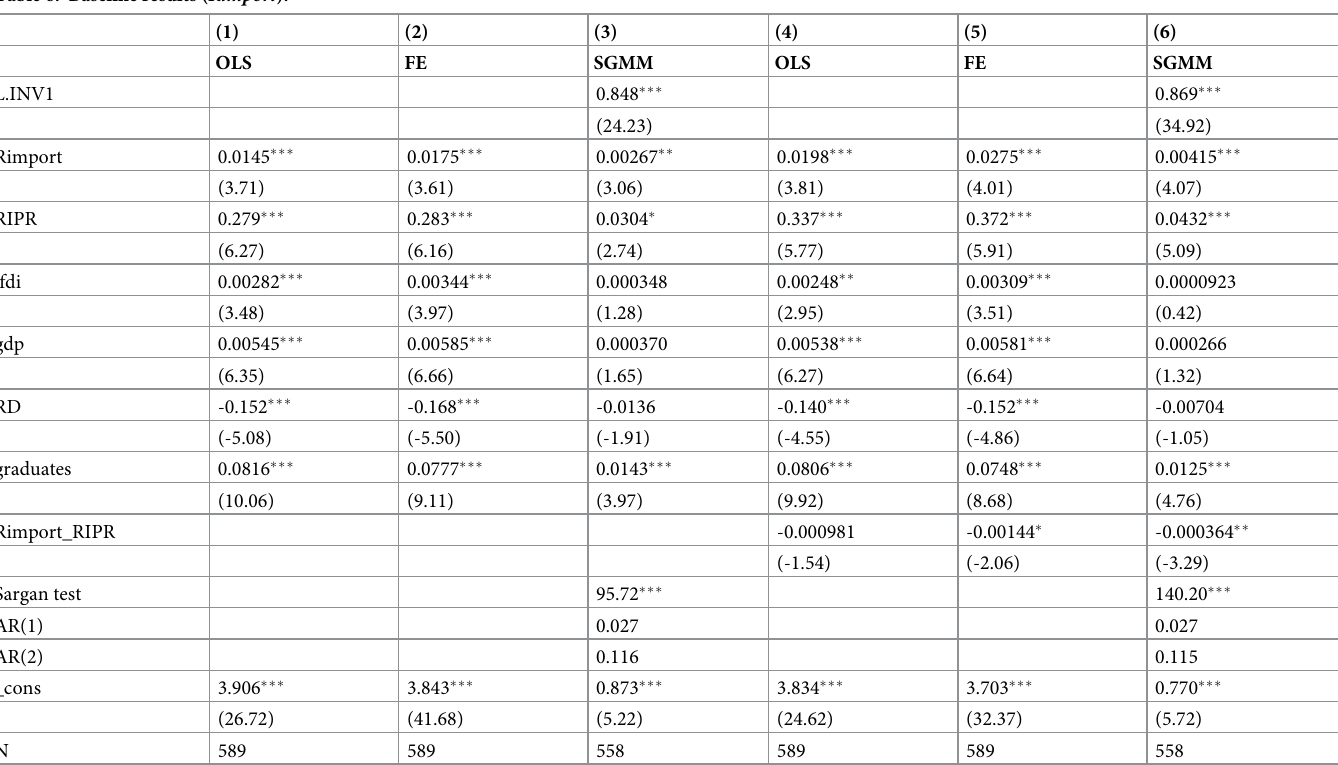
Table 6. Baseline results ( Rimport